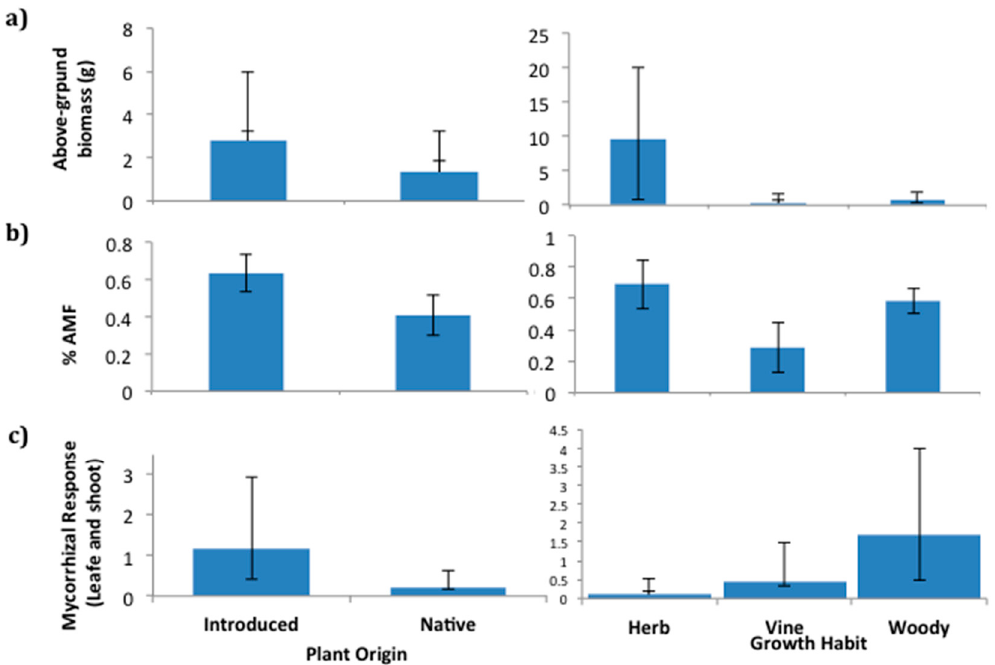
Figure 5. The mean and standard error of the ( a ) aboveground (leaves and shoots) biomass, ( b ) rate of root arbuscular mycorrhiza colonization, and ( c ) mycorrhizal response of plant species by plant origin: Introduced and native (left panels) and growth habit: Herb, vine, and woody (right panels). The aboveground mycorrhizal response was calculated as the ratio of the leaf and shoot biomass gained in live soil over the same biomass gained in soil treated with fungicide.